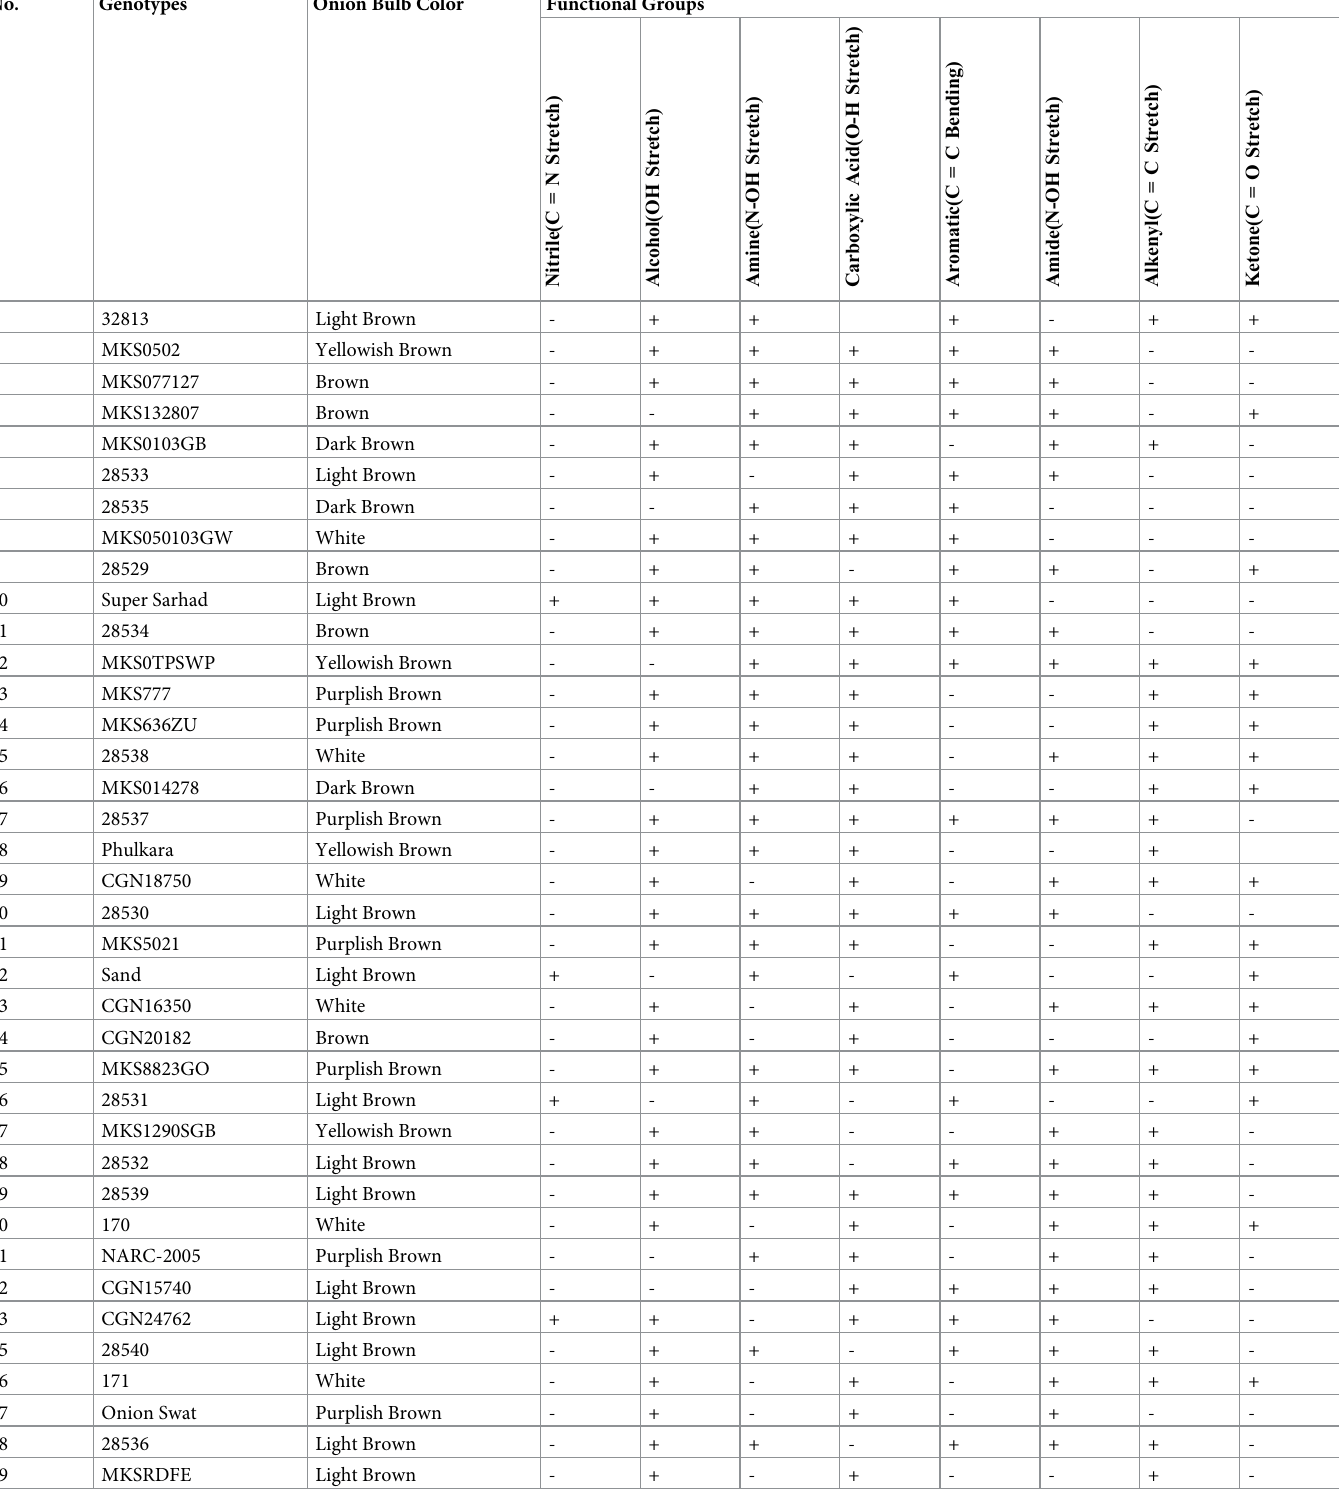
Table 1. Accessions showing the presence of different functional groups at different wave lengths indicating different phytochemicals.